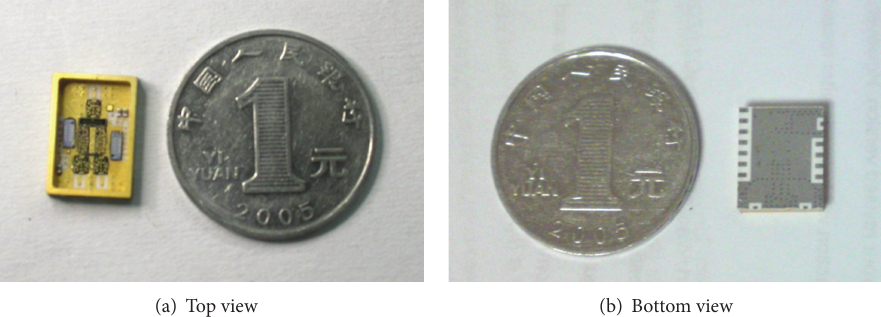
Figure 13: The fabricated compact polarization tracking